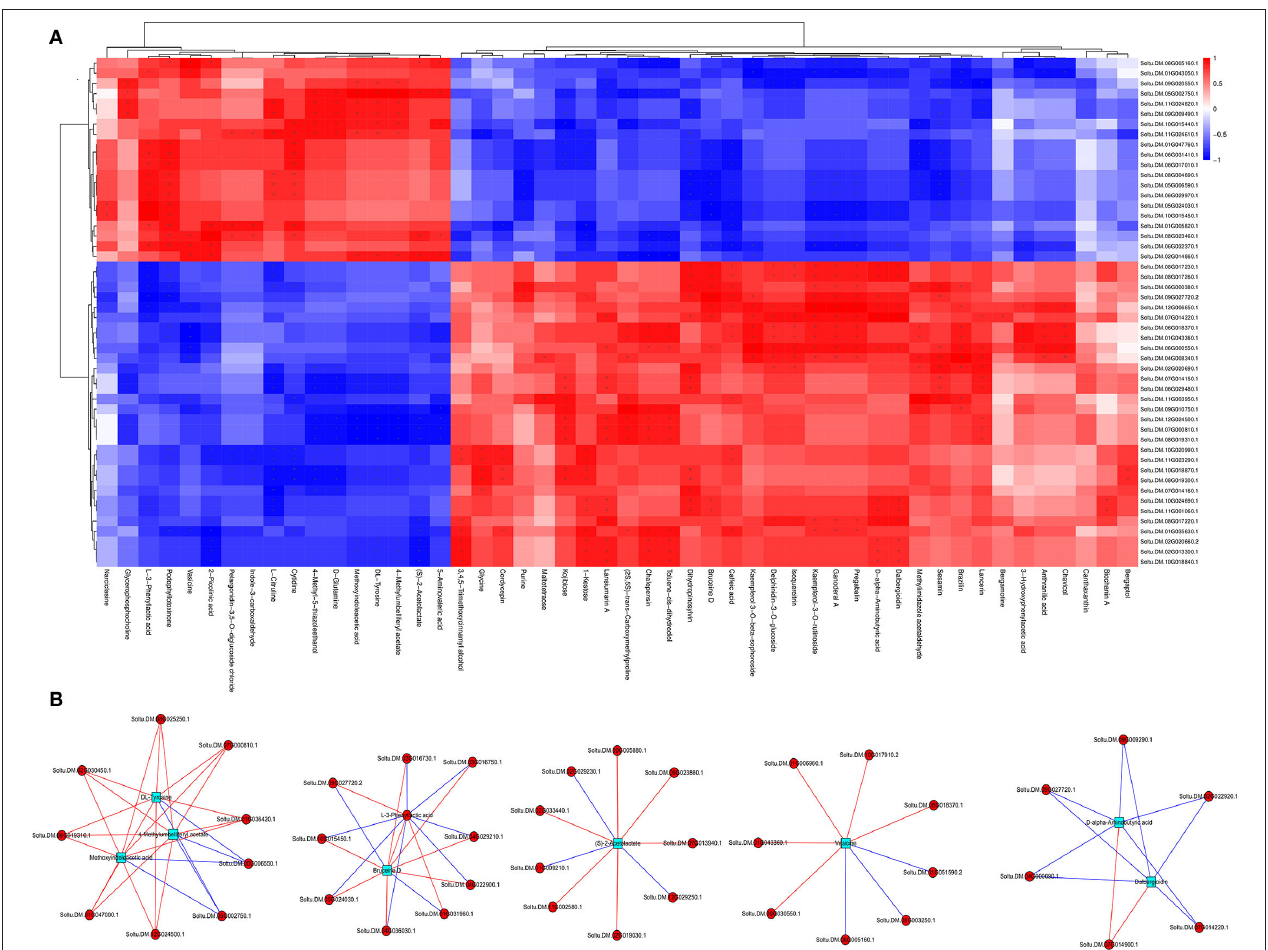
FIGURE 7 | Correlation heat map (A) and network regulation map (B) between different genes and different